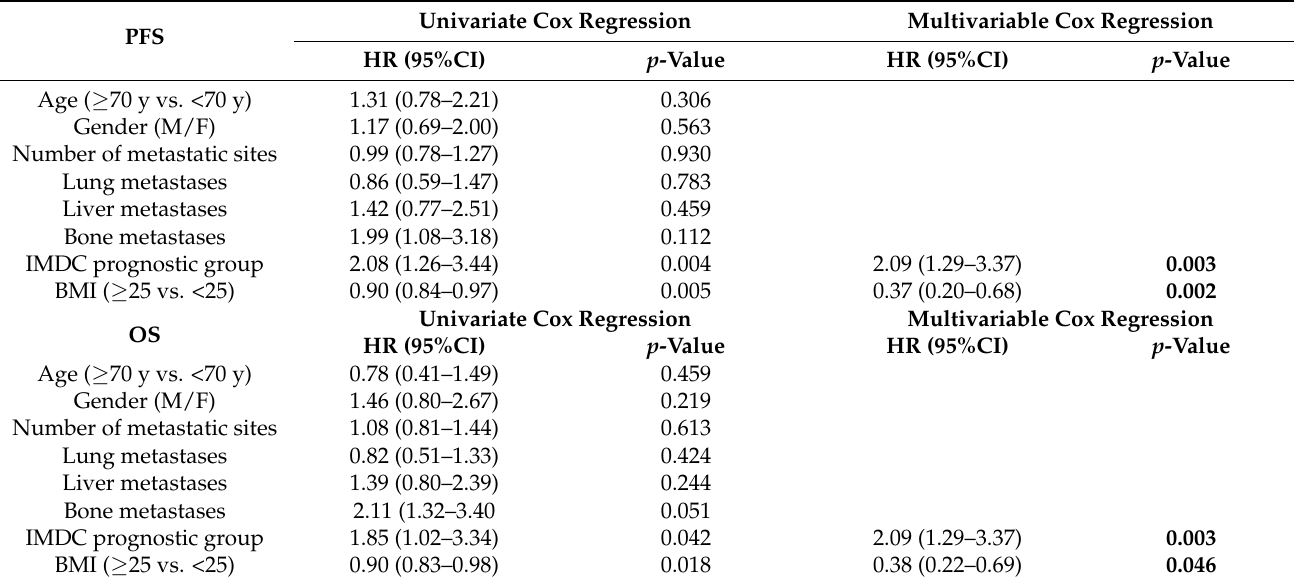
Table 3. Univariate and multivariate analyses of predictors of progression-free survival and overall survival in patients treated with cabozantinib as second-line